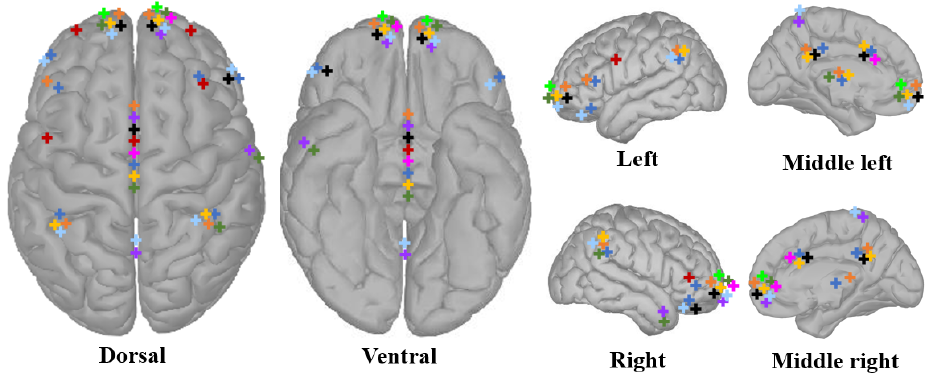
Figure 1. The cerebral cortex region of self-information